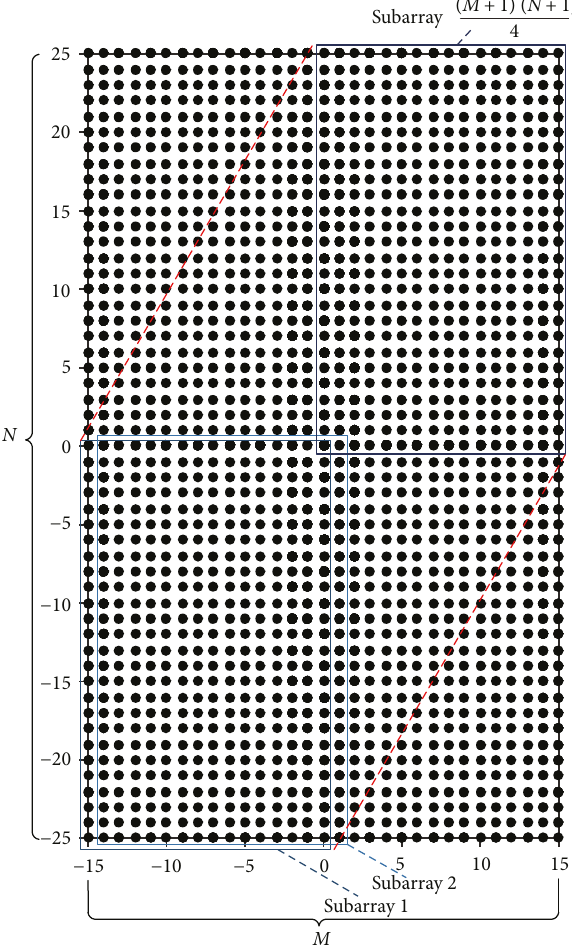
Figure 2: Subarray division in the available DCA, and M = 2 N and N = 2 N y − 3